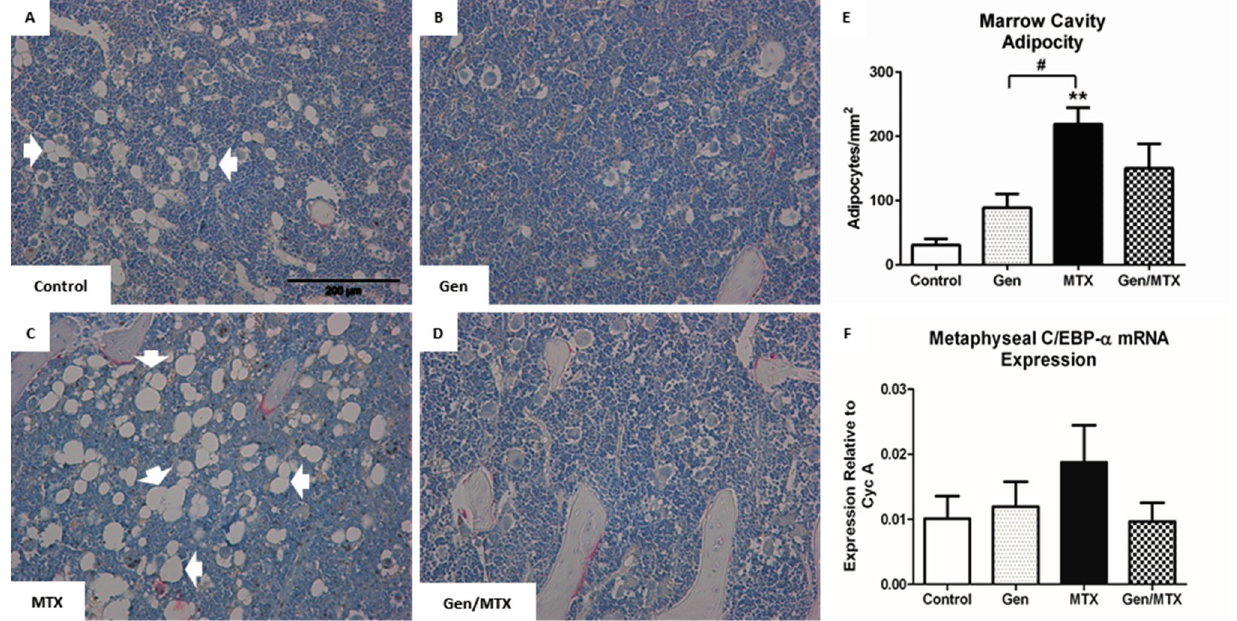
Figure 6. Changes in adipocyte density within the lower secondary spongiosa of the tibia in rats following various treatments. ( A – D ) Representative photographs (20×) of sections stained with H&E for control, genistein (Gen), MTX, and Gen + MTX groups, respectively. Adipocytes (white arrows) are easily identified as empty spaces within the marrow cavity which are encased by a membrane; ( E ) The density of adipocytes was quantified as the number of adipocytes/mm 2 of marrow cavity excluding bone area; ( F ) Adipogenesis transcription factor CCAAT/enhanced binding protein- α (C/EBP α ) relative mRNA expression as quantified via RT-PCR. n = 6, ** p < 0.01 vs. control, and # p < 0.05 between Gen and MTX